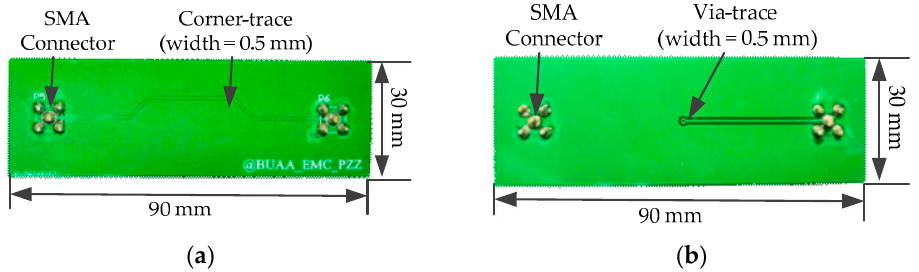
Figure 7. The one-trace validated structures. ( a ) Corner trace; ( b ) via trace.